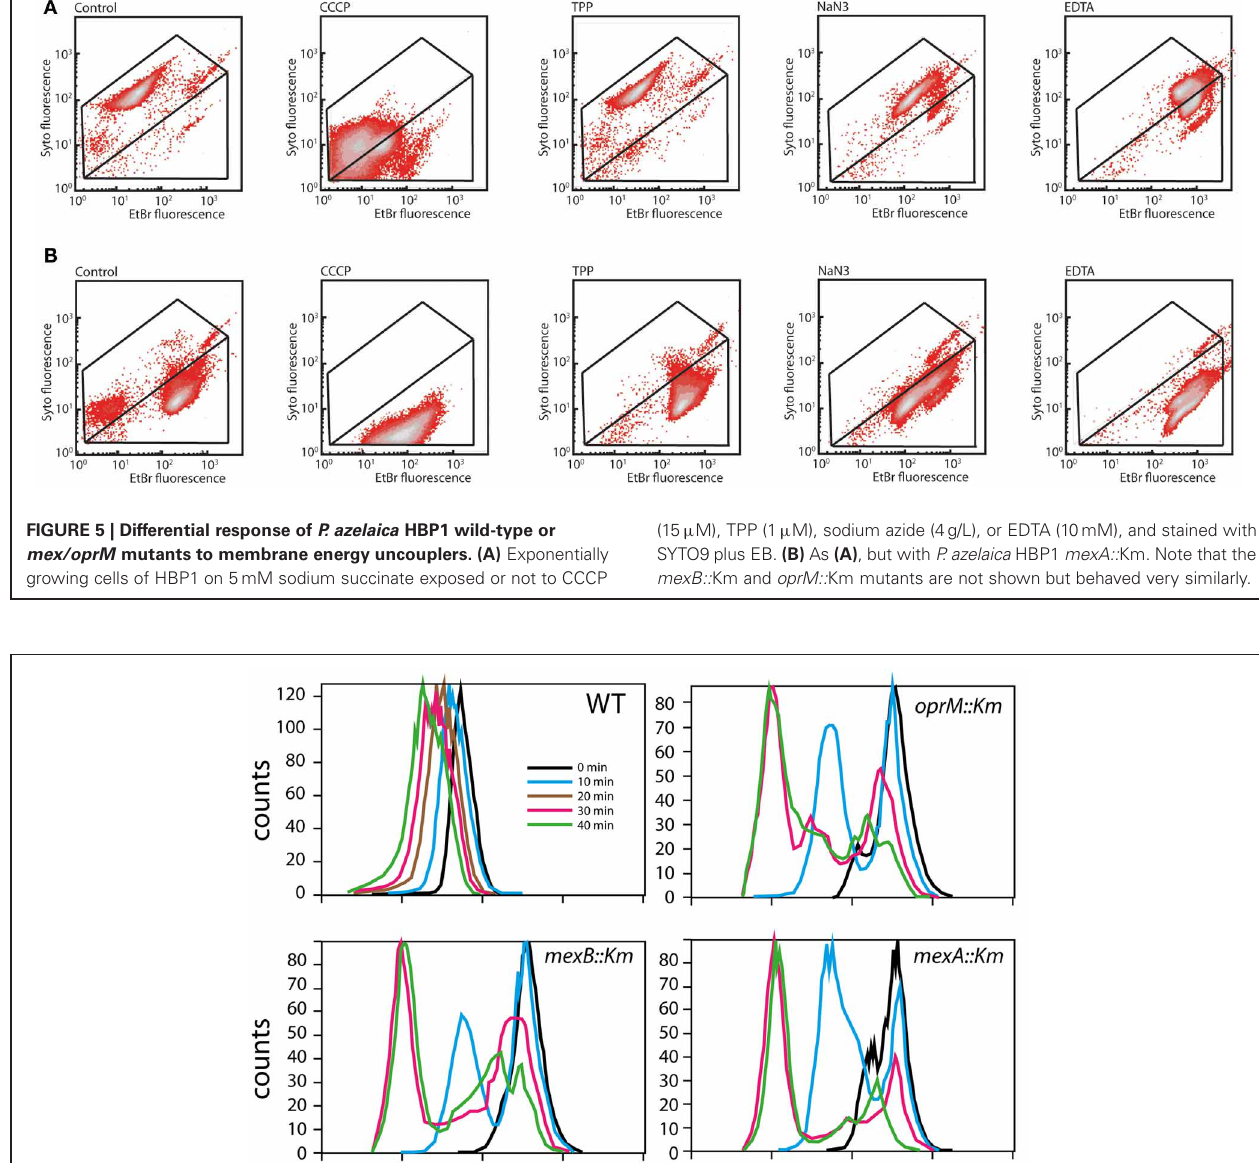
lower than wild-type in non-exposed and TPP-exposed